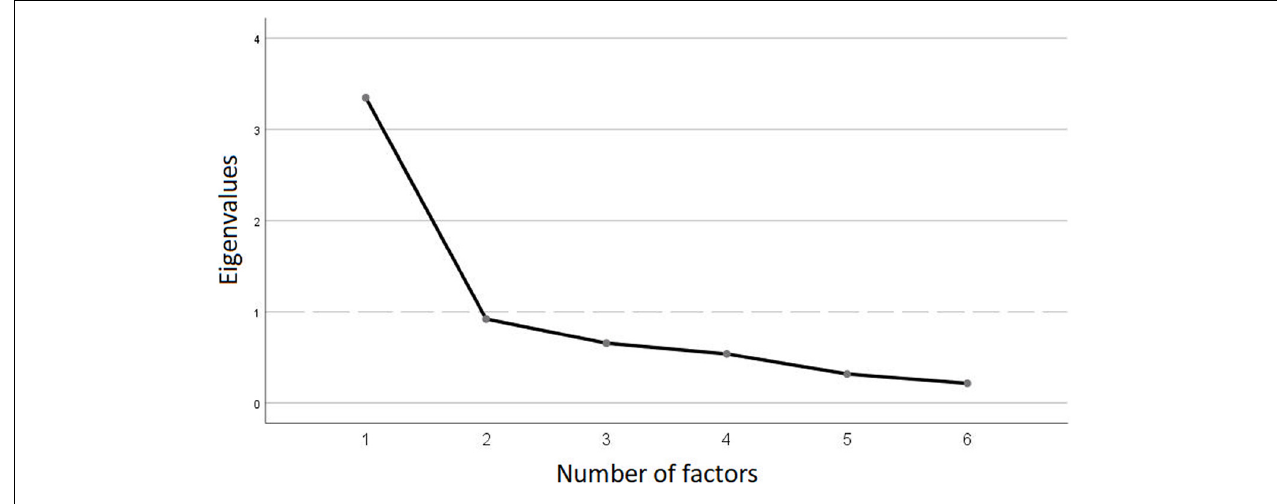
FIGURE 1 | Scree-plot for the F-BISS scale. Dashed line represents the Kaiser criterion.